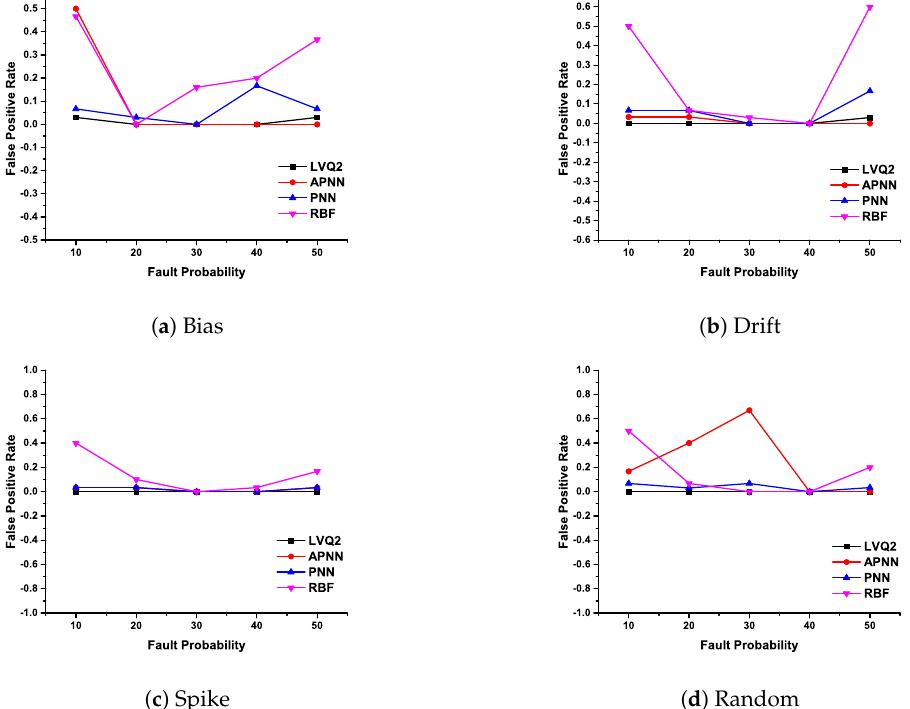
Figure 9. False Positive Rate of various faults with different